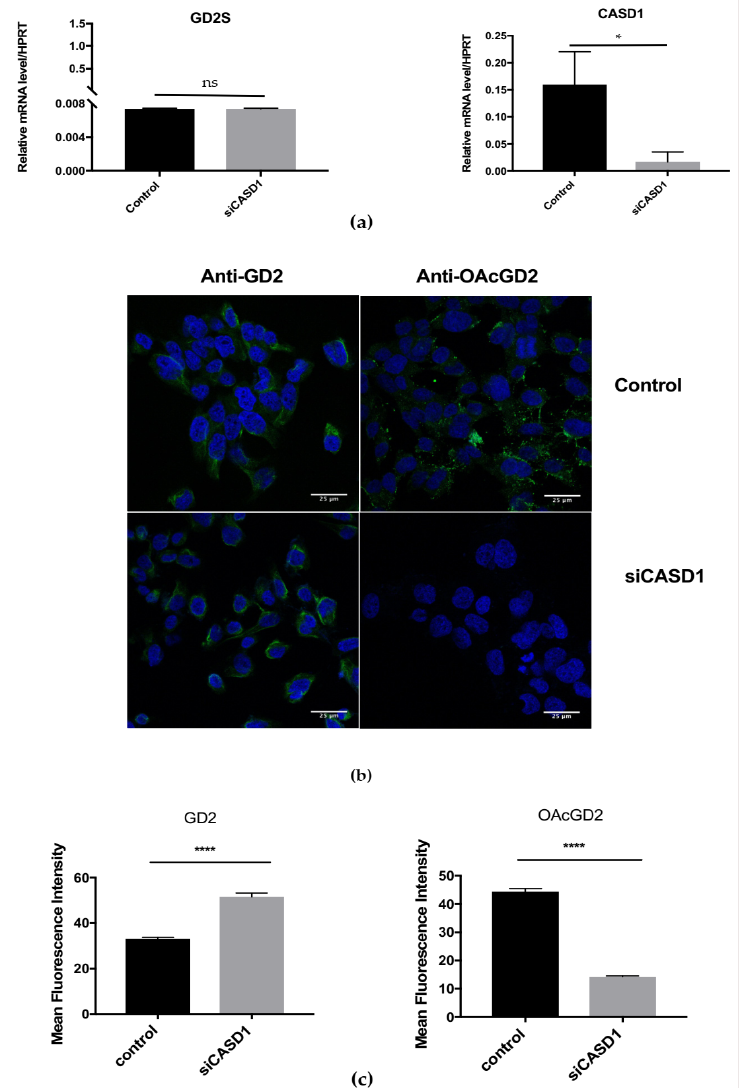
Figure 5. Reduced O AcGD2 expression in SUM159PT cells depleted for CASD1 expression using siRNA strategy. ( a ) qPCR quantification of GD2S and CASD1 expression in transiently transfected and control SUM159PT cells ( n = 3). Results were normalized to the expression of HPRT mRNA. ( b ) Representative images of the analysis of GD2 and O AcGD2 expression in SUM159PT cells using immunocytochemistry and confocal microscopy ( n = 3). Cells were incubated with an anti-GD2 and the anti- O AcGD2 mAb and gangliosides were visualized using IgG conjugate Alexa Fluor 488. The nuclei were counterstained with DAPI. All of the images were taken in the same settings. Scale bar: 25 µ m. ( c ) Quantification of the mean fluorescence intensity of GD2 and O AcGD2. Statistical difference using unpaired t -test: * p < 0.5; **** p < 0.0001; ns: not